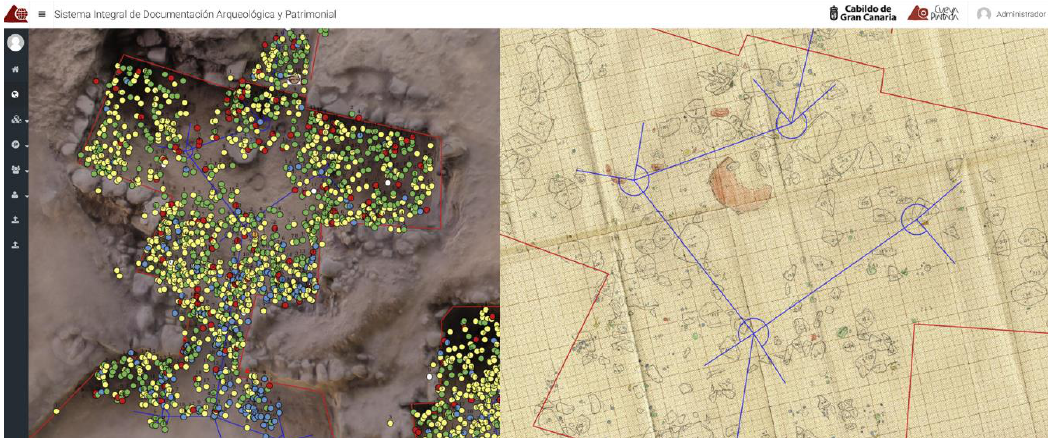
Figure 13. 3D SDI showing the orthophoto of the “Cueva Pintada” and points that link to information about the different assets and documentation plans found (right); and an example of the linked data (left): existing analog plan of the site with details of different elements found, the delimitation of the structure (in red) and the lighting infrastructure (in blue).